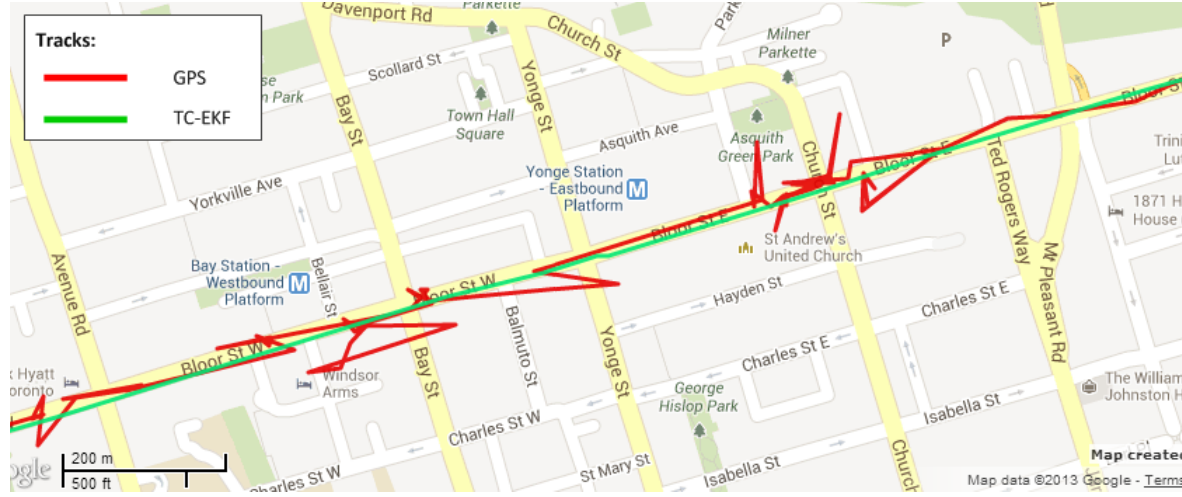
Figure 17. Performance in noisy GPS signal conditions during outage # 2, 3 and